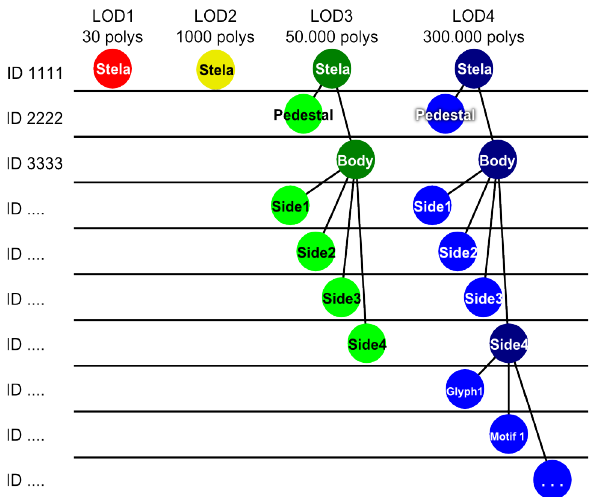
Figure 2. Database structure to store semantically segmented